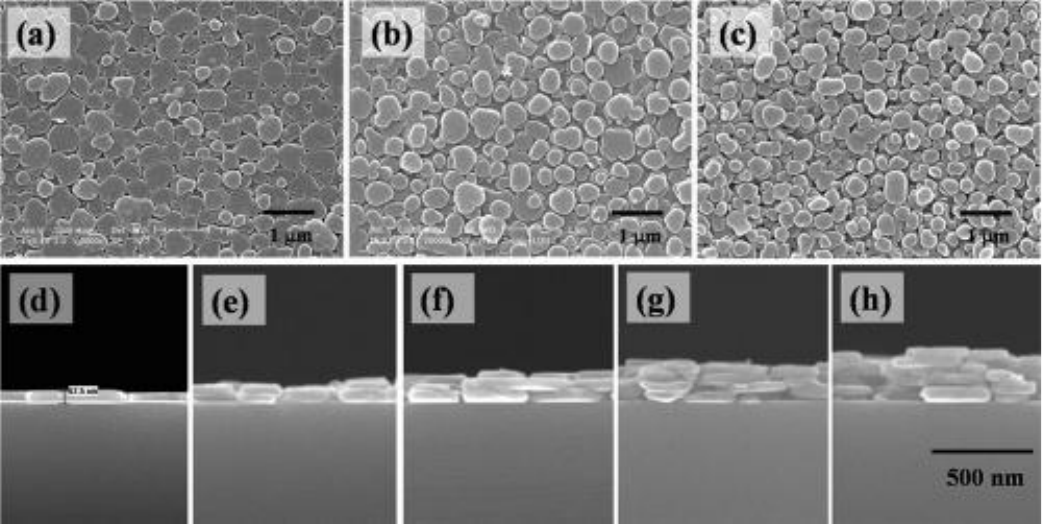
Figure 6. SEM images of the monolayer of LbL LDH nanocrystals: 1 layer (L) ( a ); 3 L ( b ); and 5 L MgAl-LDH/Si ( c ); Cross-sectional views of 1 L ( d ); 2 L ( e ); 3 L ( f ); 4 L ( g ) and 5 L ( h ) samples. Reprinted with permission from [49], © American Chemical Society, 2007.